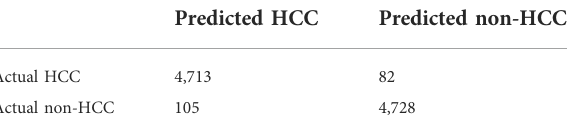
TABLE 2 Confused matrix of the 21 selected